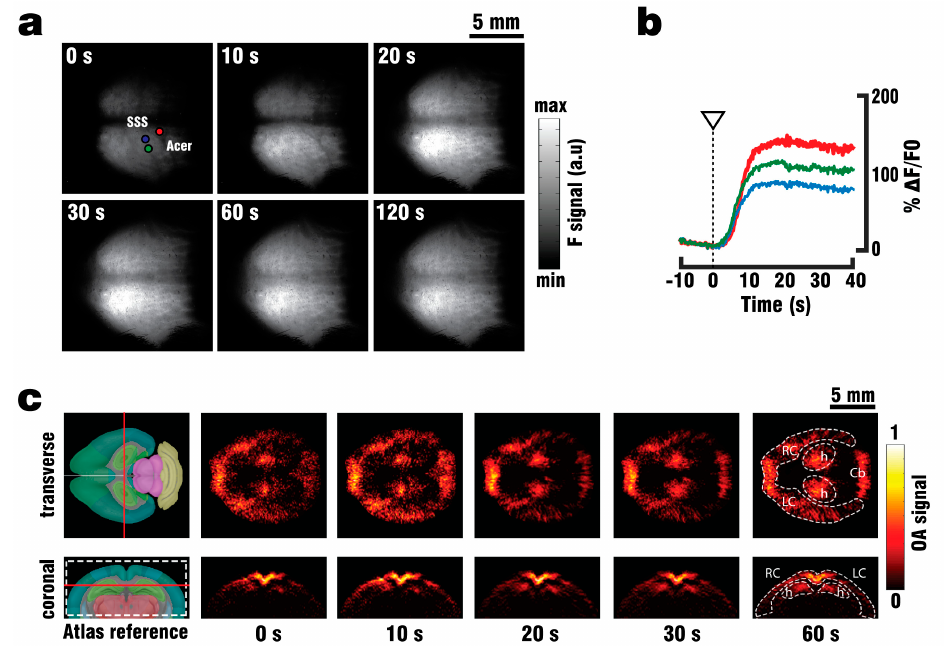
Figure 3. ( a ) Planar wide-field fluorescence images of the blood clearing procedure in a GCaMP6f-labeled mouse. F: fluorescence; SSS: superior sagittal sinus; Acer: anterior cerebral artery ( b ) Time-traces of the normalized fluorescence data are shown from regions of interest indicated in panel A. While overall signal intensity increases as blood is removed, planar fluorescence cannot distinguish signal changes at different depths. ( c ) Transverse orthoslice from the volumetric FONT recordings at 1.5 mm depth is shown along with the corresponding coronal slice during perfusion. After 60 s, the median FONT signal increases, enabling the identification of several brain structures. L/RC: left/right cortex; h: hippocampus; Cb: Cerebellum. Red lines indicate slice positions for both views. Reference images are taken from the Allen Mouse Common coordinate Framework [35].